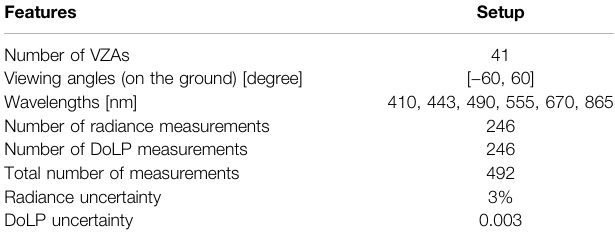
TABLE 3 | Characteristics of the